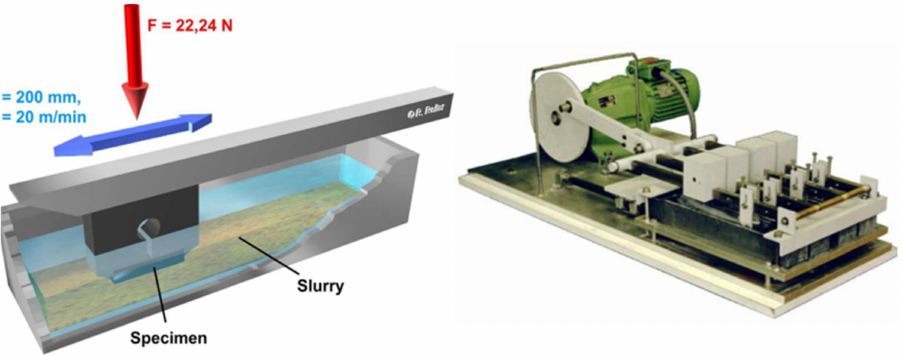
Figure 1. ASTM G75 (Miller Test) [10].